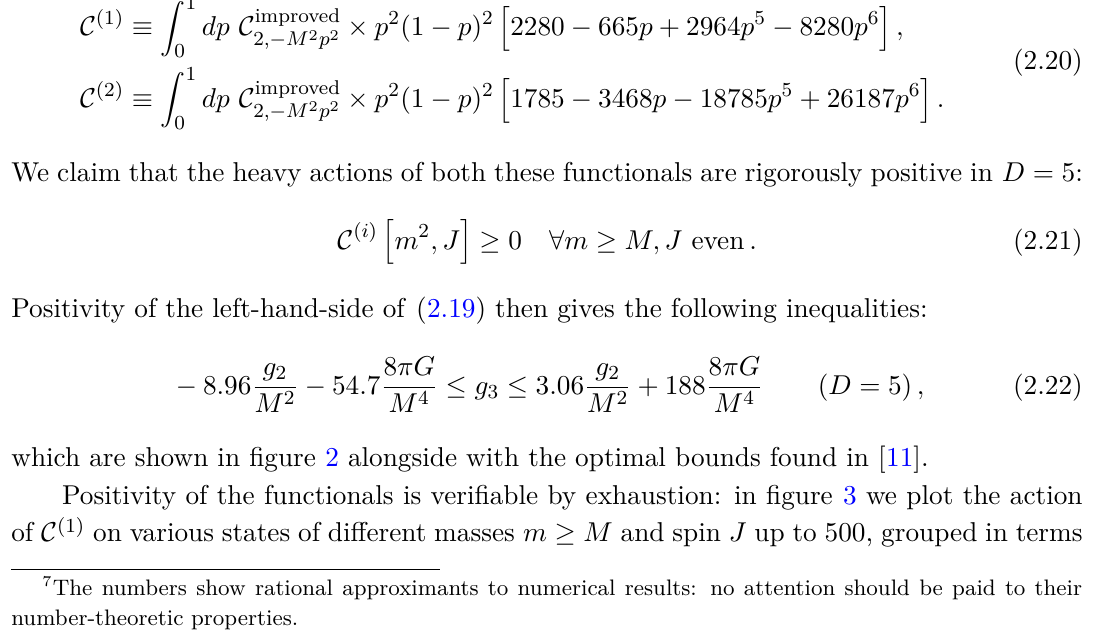
JHEP11(2021)164